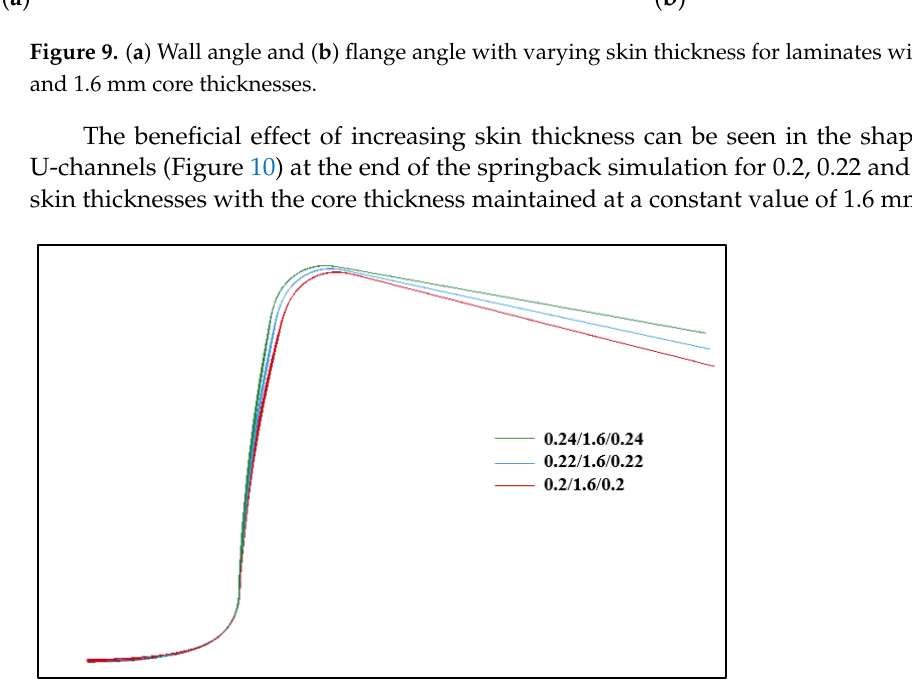
Figure 10. Shapes of U-channels after springback, with 0.2, 0.22, 0.24 mm skin thickness and a constant core thickness of 1.6 mm.